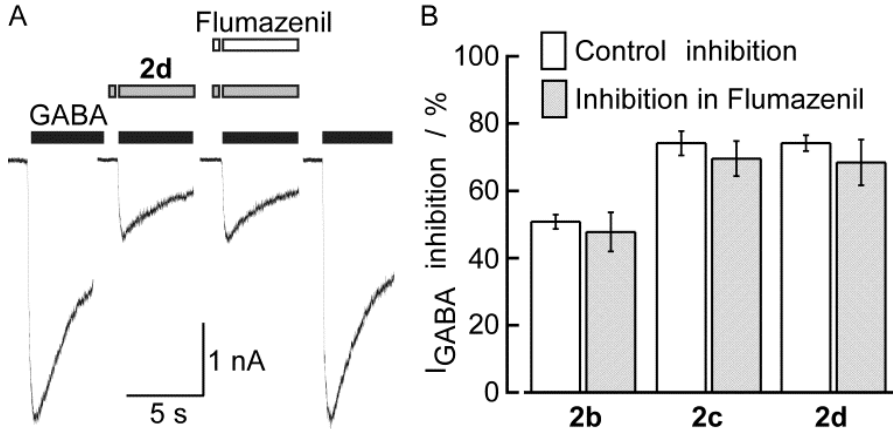
channels were Figure 10. The inhibitory effects of compounds 2 on the GABA A independent of the benzodiazepine binding site. ( A ) First and last traces represent control currents induced by GABA (300 μ M). The two middle traces were recorded in 2d (100 μ M) alone or plus flumazenil (10 μ M), all traces are from the same neuron. ( B ) Each pair of bars represents the mean inhibition of I induced by DBTDs, before (Control) GABA and in the presence of flumazenil. Lines over the bars indicate the